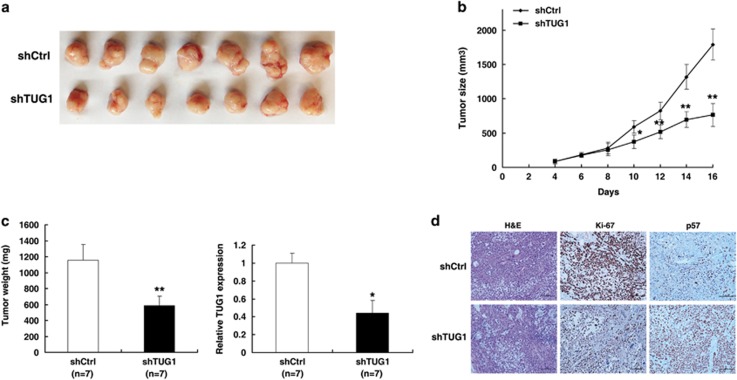
The impact of TUG1 on tumorigenesis in vivo. (a and b) Scramble or shTUG1 was transfected into AGS cells, which were injected into nude mice (n=7). The tumor volumes were calculated every 2 days after injection. The bars indicate S.D. (c) The tumor weights are shown as means of tumor weights±S.D. qRT-PCR was performed to detect the average expression of TUG1. (d) Histopathology of xenograft tumors. The tumor sections underwent H&E staining and IHC staining using antibodies against Ki-67 and p57. Bar, 100μm. Error bars indicate means±S.E.M. *P<0.05, **P<0.01